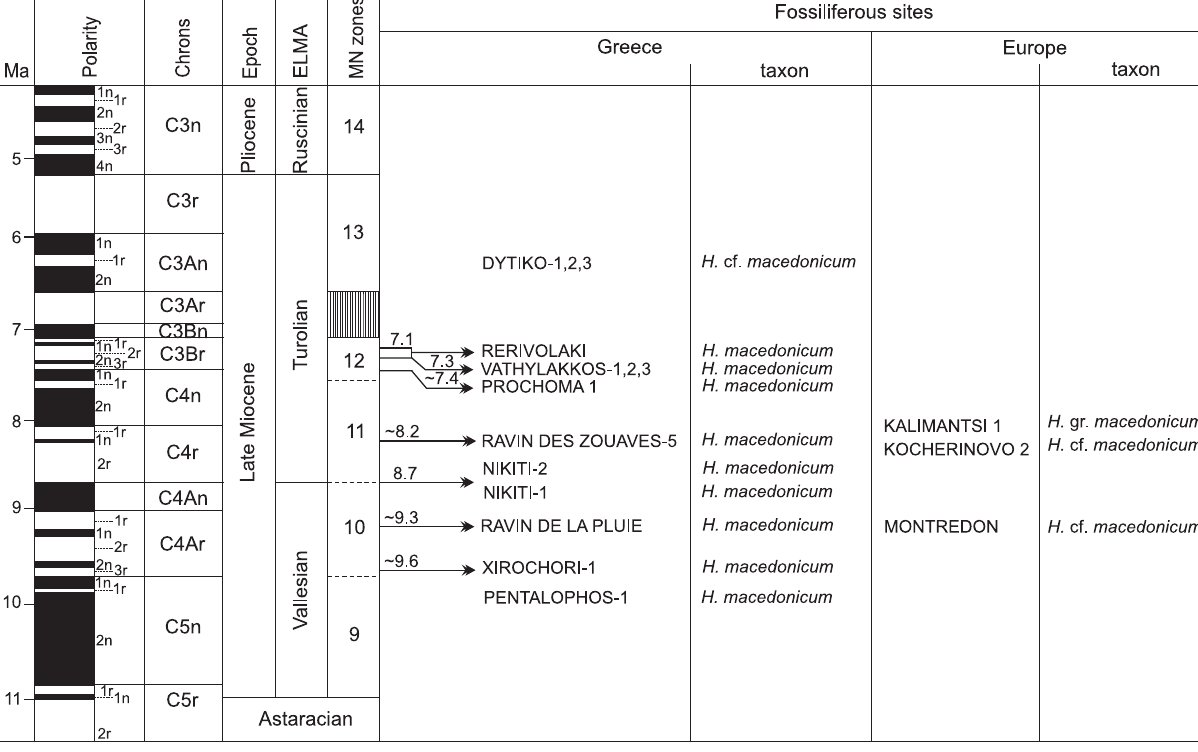
Fig. 9. Stratigraphic table indicating the distribution of Hipparion macedonicum in Europe. The geomagnetic time scale is from Cande and Kent (1995). The shaded area in the MN zones express the different opinions for the MN 12/13 boundary; according to Sen (1997) it is at ~7.0 Ma while according to Steininger et al. (1999) it is at ~6.6